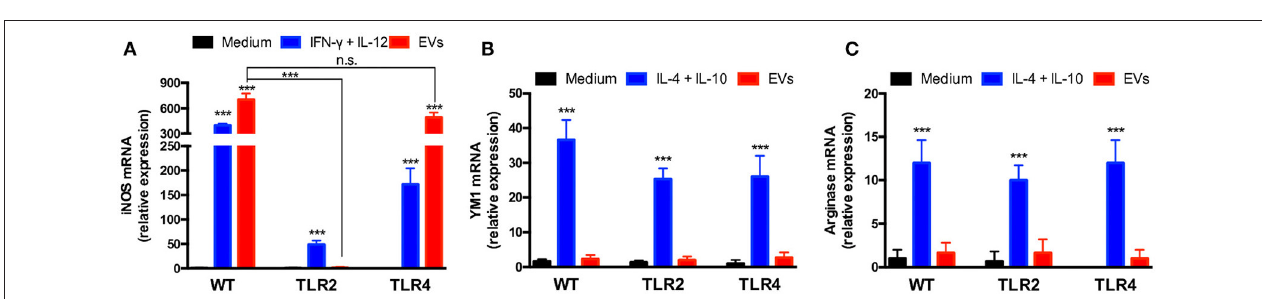
FIGURE 6 | Involvement of TLR2 in the activation of bone marrow-derived macrophages (BMDMs) by T. interdigitale EVs. BMDMs from WT, TLR2 − / − , and TLR4 − / − mice were stimulated for 6h with EVs (10 7 particles/mL). As positive control for the M1 activation, the mixture of INF- γ (2ng/mL) plus IL-12p40 (50ng/mL) was used. For M2 activation, a mixture of IL-10 plus IL-4 (50ng/mL both) was used. The medium alone was used as negative control. RNA was extracted and converted into cDNA and real-time PCR was used to evaluate the relative expression of iNOS ( A ), Ym-1 ( B ), and arginase-1 ( C ). Data are representative of 3 experiments. The results are expressed as means ± SEM and are compared to the results obtained for the negative control. *** P < 0.001, and non-significant differences (n.s.).